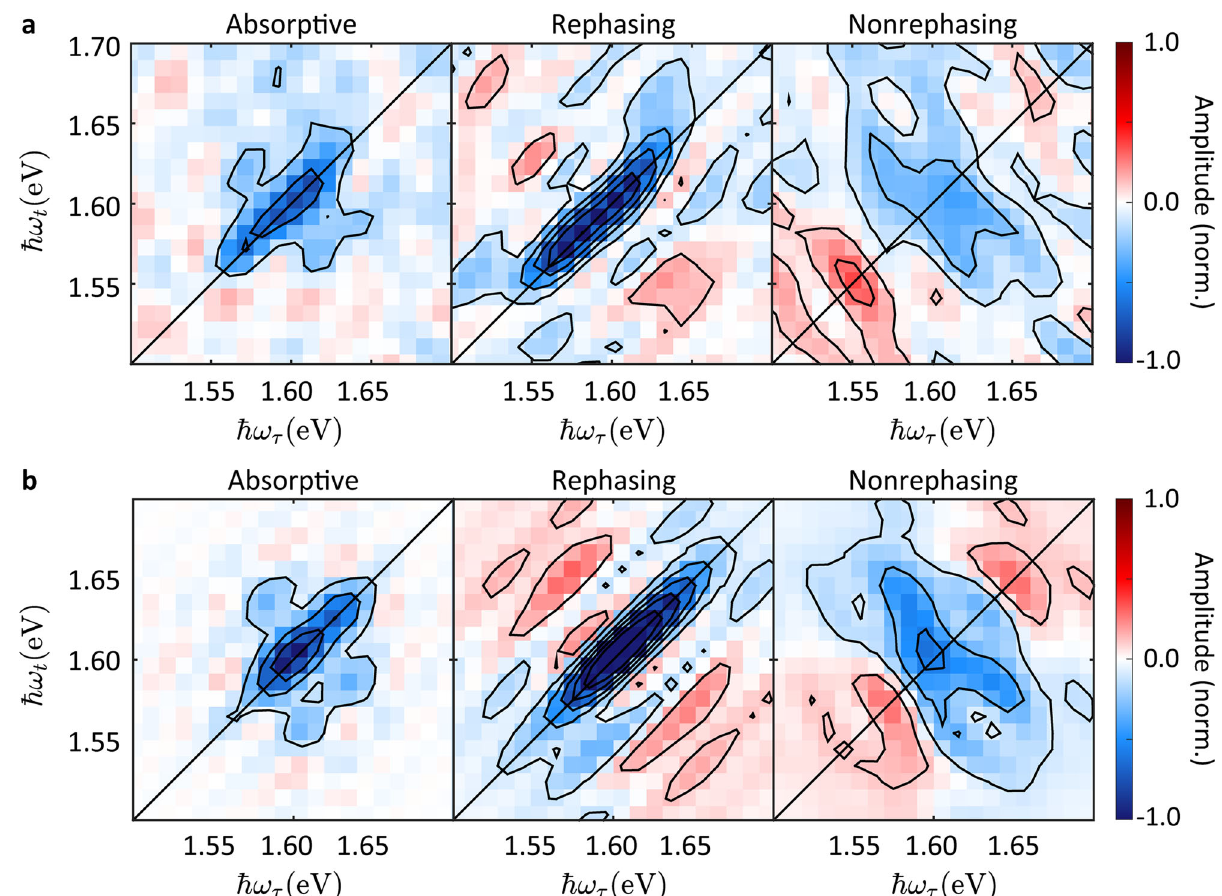
Fig. 5 Absorptive (left), rephasing (middle), and nonrephasing (right) real-valued 2d maps at T = 50 fs. a Experiment. b Simulation using the deduced optimal S =